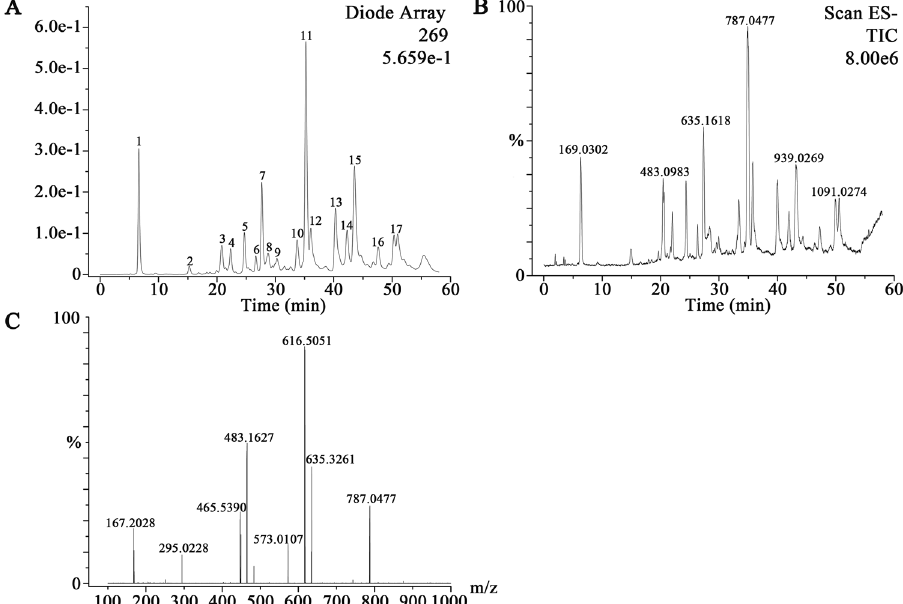
Figure 7. ( A ) HPLC analysis of Turkish galls ethyl acetate fraction. Peak assignment: (1) Gallic acid, (2)–(4) Digalloyl-glucoside, (5)–(9) Trigalloyl-glucoside, (10)–(12) Tetragalloyl-glucoside, (13)–(16) Pentagalloyl- glucoside peak, (17) Hexagalloyl-glucoside. ( B ) HPLC-MS analysis of Turkish galls ethyl acetate fraction. ( C ) HPLC-ESI-MS/MS data of m/z 787.0477, which identified as